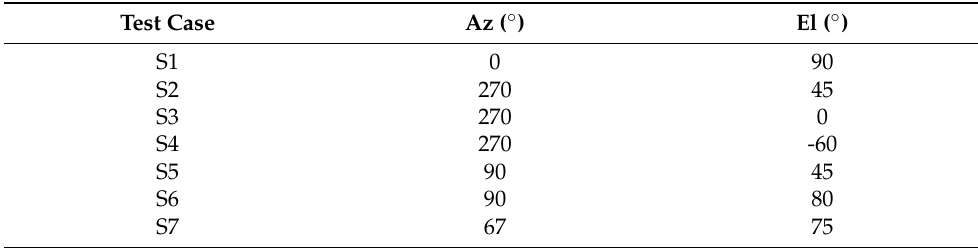
Table 6. Summary of test cases with variable illumination conditions for the pose estimation with the chaser-fixed camera.